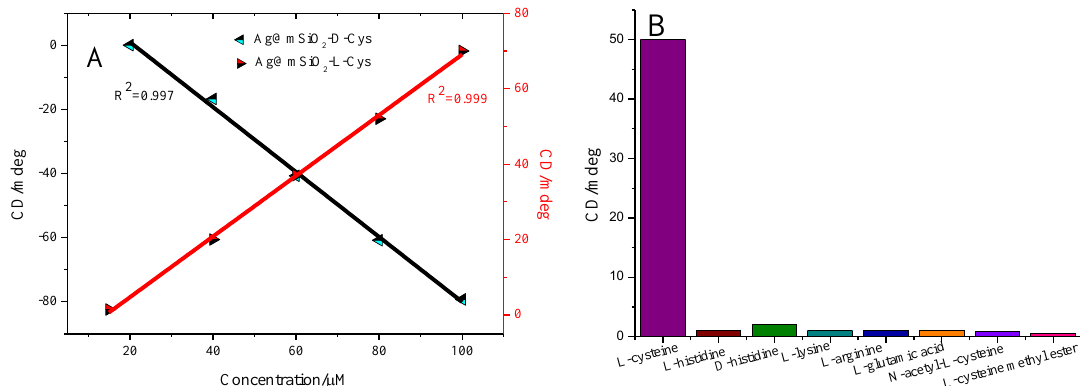
Figure 6. ( A ) The intensity of the circular dichroism (CD) signal at 265 nm as a function of the concentration of L -Cys and D -Cys; ( B ) CD responses of Ag@mSiO 2 to amino acids at 265 nm. The concentration of each amino acid was 1 mM.